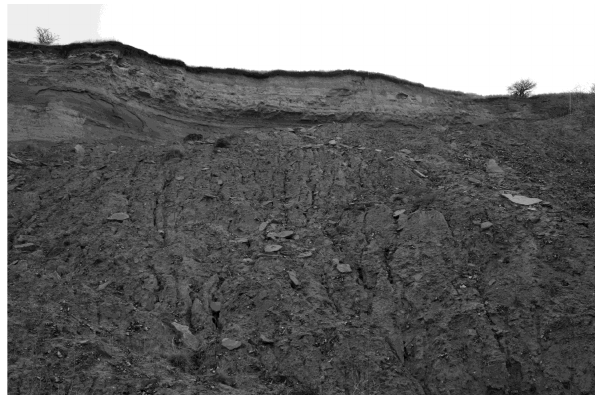
Fig. 25. The erosion furrows running along the deposits recently accumulated in the gully. (A) The right secondary gully; (B) the left secondary gully; and (C) the common gully at the